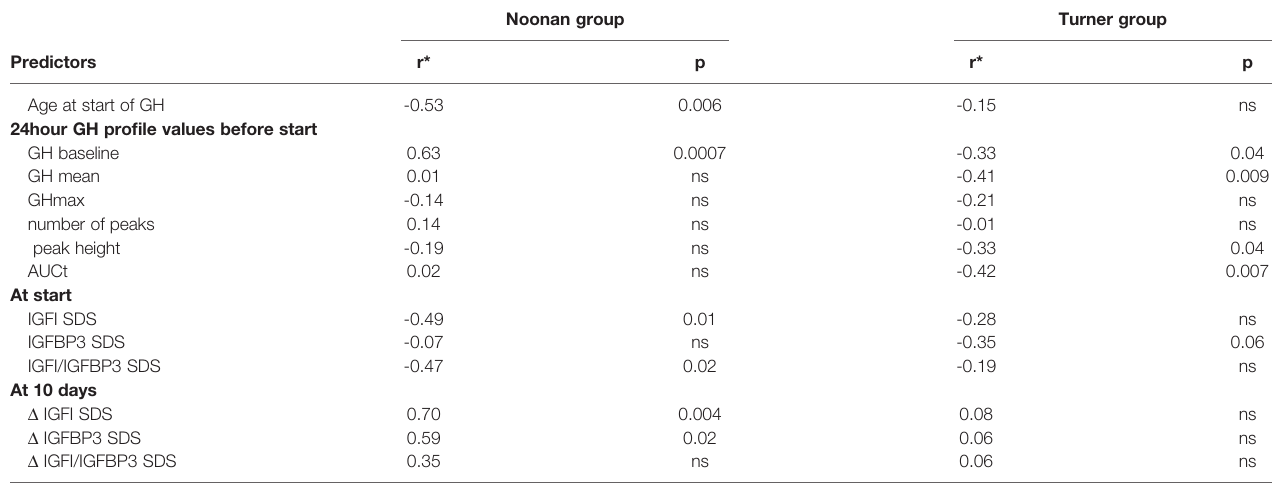
TABLE 3 | Correlation coef fi cients for the fi rst-year growth response as dependent variable, using age, different GH and IGF variables at start or at 10 days of treatment in Noonan group and Turner group,